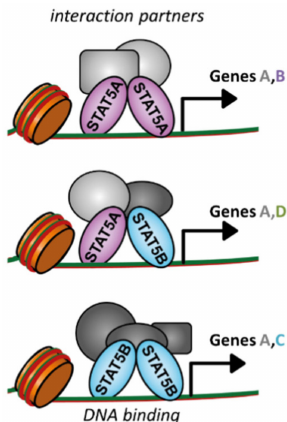
Figure 3. STAT5A and STAT5B hetero- and homodimers may induce di ff erent transcriptional programs. STAT5A and STAT5B may have unique DNA binding sites and induce di ff erent sets of target genes by interacting with distinct